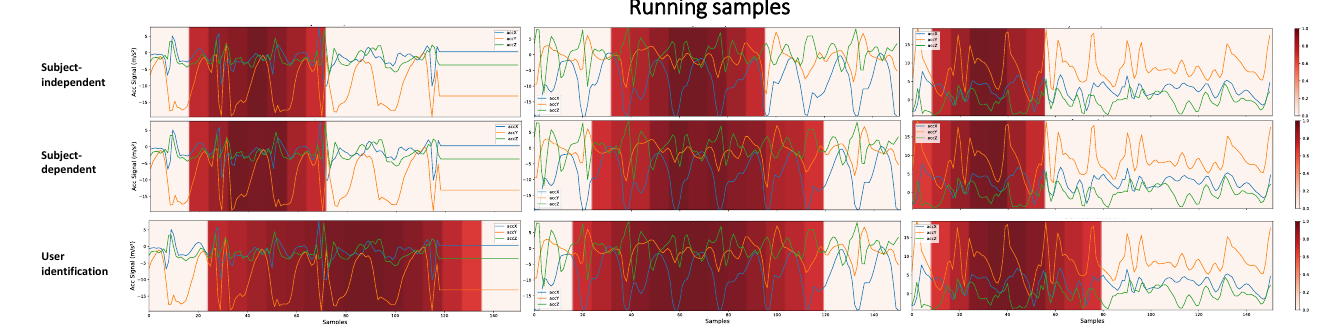
Figure 14. The most critical decision-making segments in the CNN1 architecture for HAR with SI, HAR with SD, and user identification, considering samples of the Running class with different subjects. To obtain the heatmaps, a threshold of 0.7 was considered in the grad-CAM result in order to make the most important regions more evident.